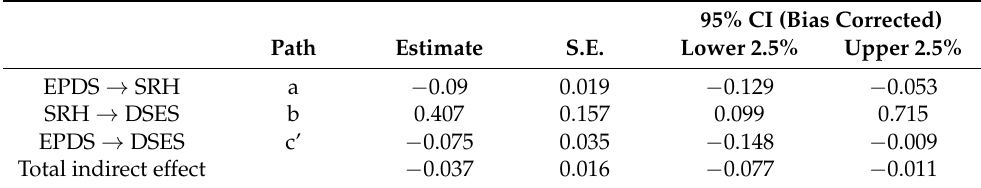
Table 3. Unstandardized estimates from the mediation analysis.